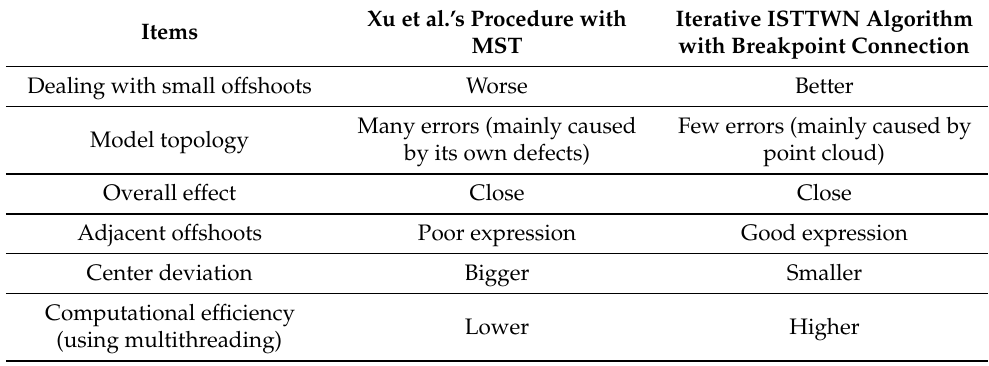
Table 8. Comparison of the skeleton extraction algorithms. Xu et al.’s Procedure with Iterative ISTTWN Algorithm Items MST with Breakpoint Connection Dealing with small offshoots Worse Better Many errors (mainly caused Few errors (mainly caused by Model topology by its own defects) point cloud) Overall effect Close Close Adjacent offshoots Poor expression Good expression Center deviation Bigger Smaller Computational efficiency Lower (using multithreading)